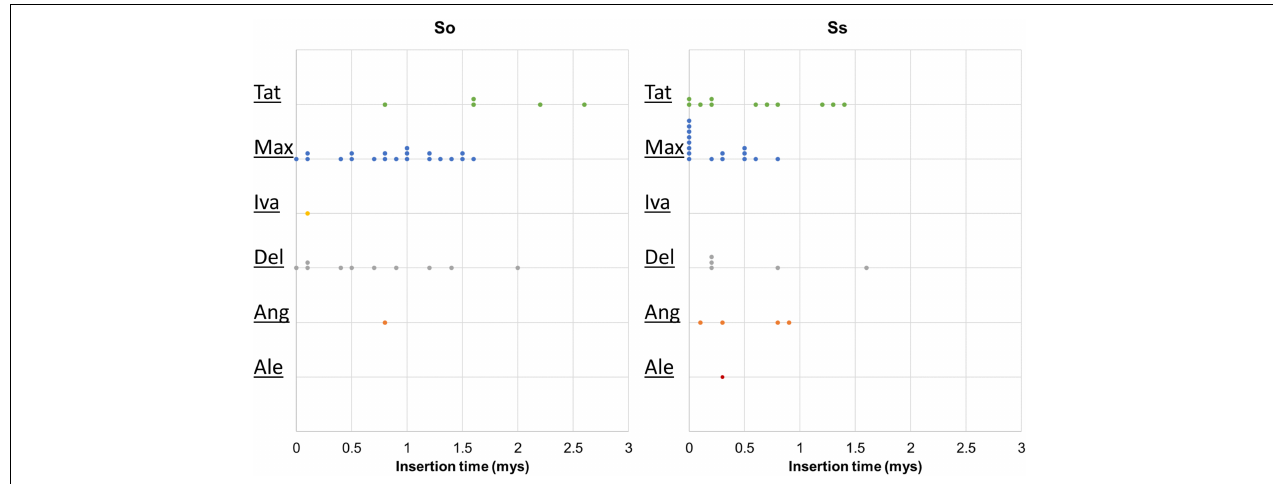
FIGURE 6 | Insertion time of LTR retrotransposon families. The insertion time of LTR retrotransposon families in So (left graph) and Ss (right graph) BACs are shown. The X axis represents the insertion time (mys). Each dot in the graph represents insertion time of one element and these are stacked when more than one element has the same insertion time for easy visualization of copy number. The insertion time was calculated based on substitution rate of 1.3 × 10 − 8 (Ma and Bennetzen,